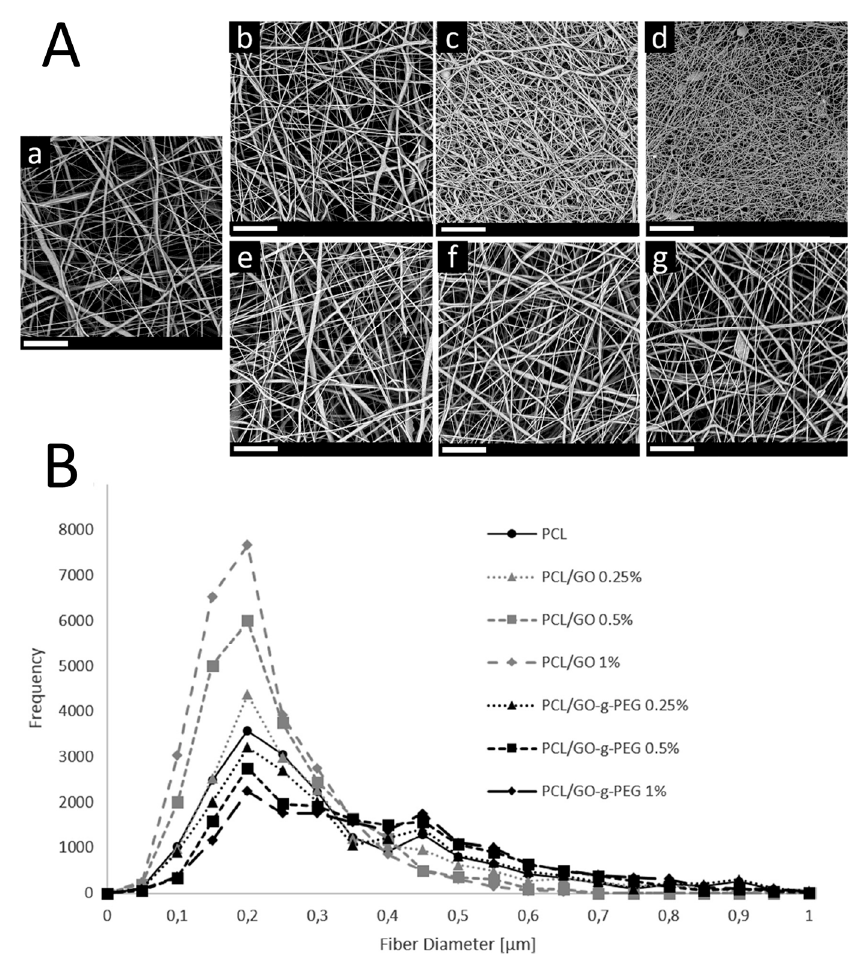
Figure 10. ( A ) SEM image of electrospun: ( a ) polycaprolactone (PCL); ( b ) PCL/GO 0.25 wt %; ( c ) PCL/GO 0.5 wt %; ( d ) PCL/GO 1.0 wt %; ( e ) PCL/GO- g -PEG 0.25 wt %; ( f ) PCL/GO- g -PEG 0.5 wt %; ( g ) PCL/GO- g -PEG 1.0 wt %. Scale bars are 20 μ m. ( B ) Diameter distribution for electrospun PCL, PCL/GO and PCL/GO- g -PEG nanocomposites obtained with ImageJ. Reprinted from [7] with permission from Elsevier.